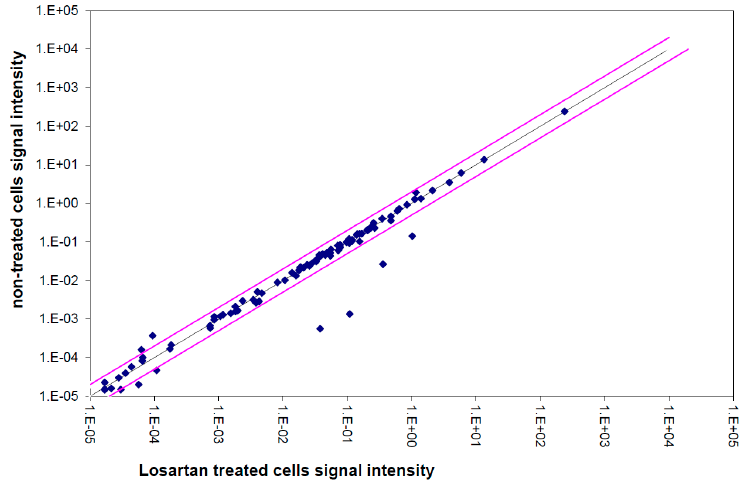
Figure 5. Correlation between the signal intensities of TGF β -pathway genes. Expression analysis in losartan-treated and untreated cells. Cells treated with losartan are plotted against untreated cells. The scatter plot shows a positive tendency with a strong correlation between the two samples. Table 3. Significantly regulated genes in WG-59 after losartan-treatment compared to untreated cells. − , downregulation; +, upregulation.